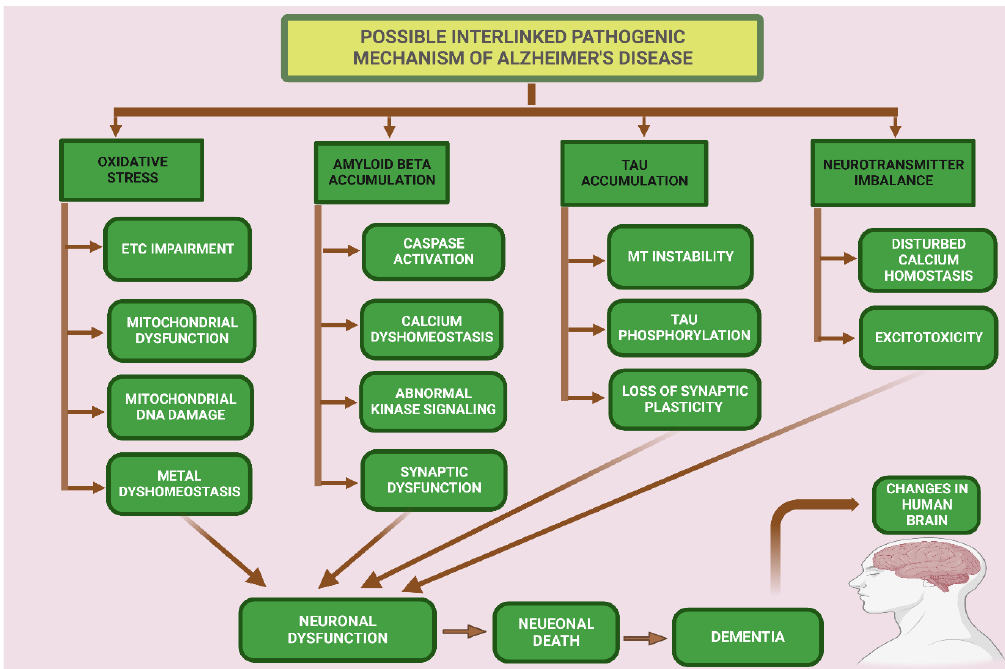
Figure 4. Pathogenic hypothesis for neuronal dysfunction in Alzheimer’s disease. Mitochondrial oxidative stress condition accelerates the electron transport system to generate more reactive oxida- tive stress and cause oxidative damage in brain cells. Aβ accumulation causes caspase activation of abnormal kinase signaling and synaptic impairment. Caspase activation increases tau phosphory- lation. Tau accumulation in cells causes microtubule instability which causes tau phosphorylation. A neurotransmitter imbalance causes disturbed calcium homeostasis and excitotoxicity. Oxidative stress, Aβ accumulation, tau accumulation, and neurotransmitter imb alances result in neuronal dys- function, which causes neuronal death and leads to dementia.